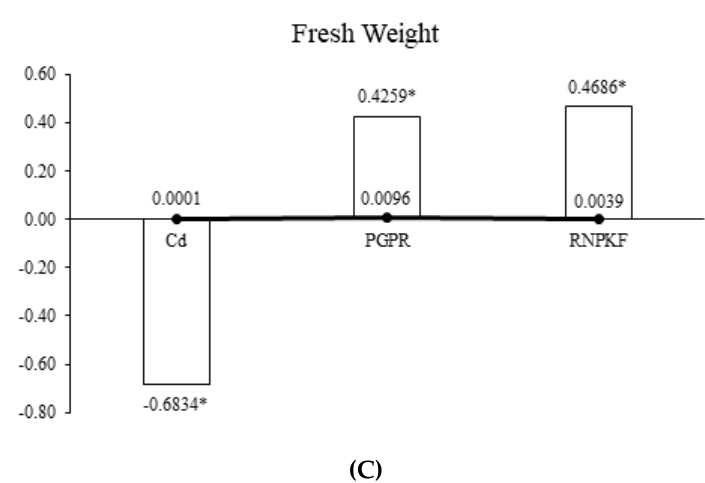
Figure 3. Effect of rhizobacteria with and without recommended NPK fertilizer on fresh weight (FW) of bitter gourd under Cd ( A ). Interaction graph of PGPR (NS1 = S. maltophilia , NS2 = A. fabrum ), RNPKF and Cd levels for fresh weight (cm) ( B ). Pearson correlation of fresh weight with different levels of Cd, ACCD PGPR, and recommended NPK fertilizer where the y -axis represents the values of correlation (bars in the graph) and x -axis probability (lines in the graph) ( C ).* = p ≤ 0.05; ns = p > 0.05 non-significant.